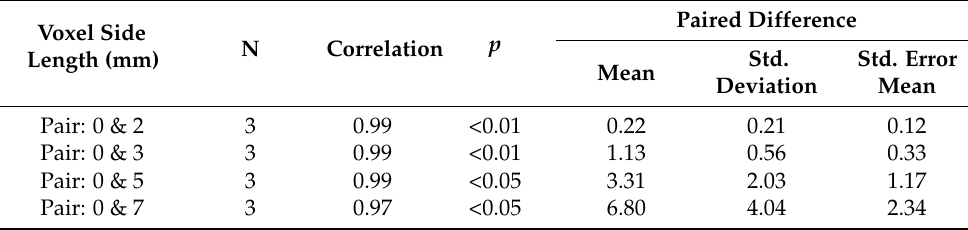
Table 5. LA value paired sample t -test: unfiltered point cloud versus filtered point cloud with voxel side lengths of 2 mm, 3 mm, 5 mm and 7 mm, respectively.